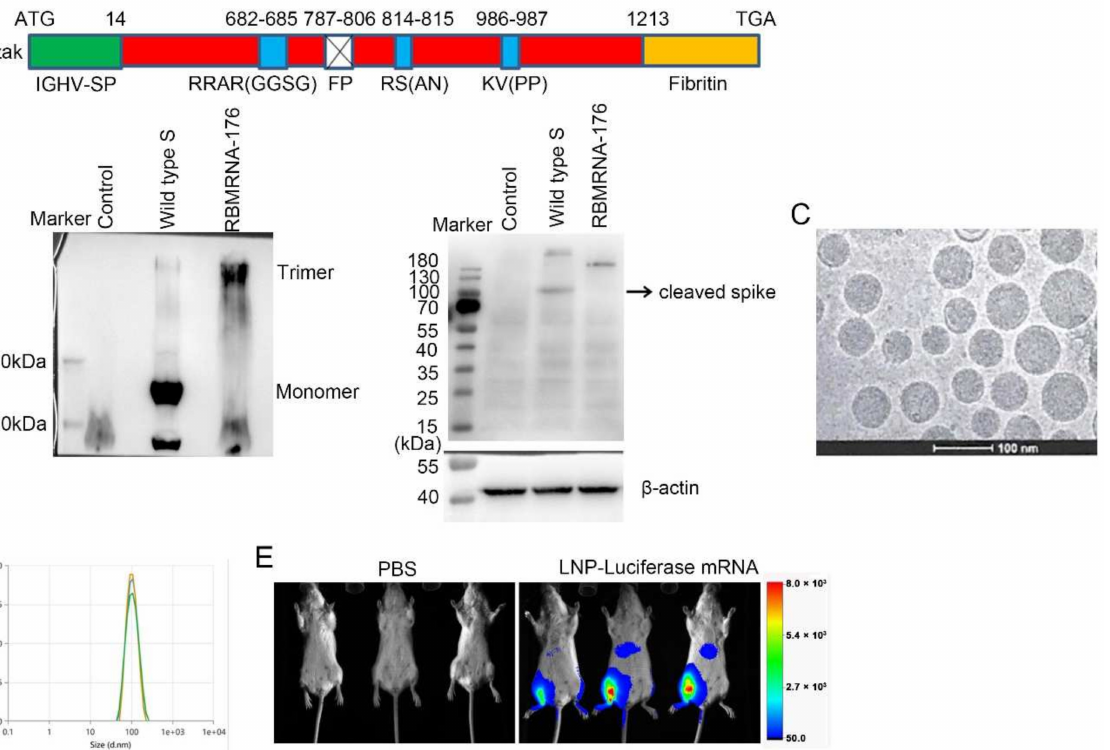
Figure 1. Construction of RBMRNA-176 ( A ). Native PAGE and Western blot analysis for the expres- sion of wild-type S protein or S ectodomain trimer in transfected cell lysates (left). SDS-PAGE and Western blot analysis for S protein cleavage (right) ( B ). Cryo-TEM of RBMRNA-176 ( C ). Particle size distribution of RBMRNA-176 was measured in triplicate using dynamic light scattering (DLS) on a Malvern ZETASIZER ( D ). Biodistribution of LNP-Luciferase 357 mRNA ( E ). BALB/c mice were administrated intramuscularly (i.m.) with 5 µ g LNP-packaged luciferase mRNA and bioluminescence was measured 3 h post injection in an In-Vivo Xtreme